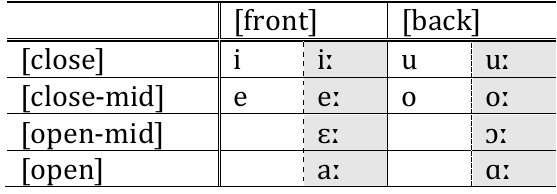
Table 7: The monophthongs of Middle